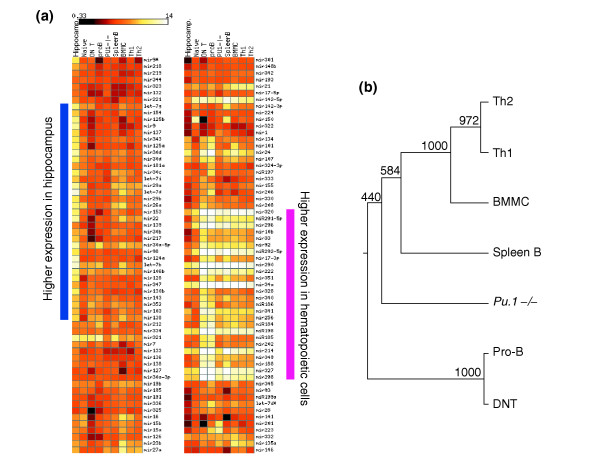
Analysis of microarray data. (a) Heat map of miRNAs expressed at least three times over the background for at least one of the samples. (b) Hierarchical clustering of hematopoietic samples (see analysis in Table 3). DN T, double-negative thymocyte; MEF, mouse embryo fibroblast.